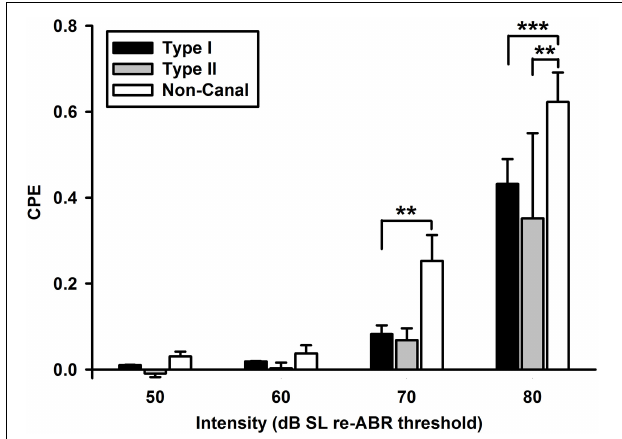
1.43 ± 0.04 and 1.37 ± 0.04 ms, respectively. Overall,